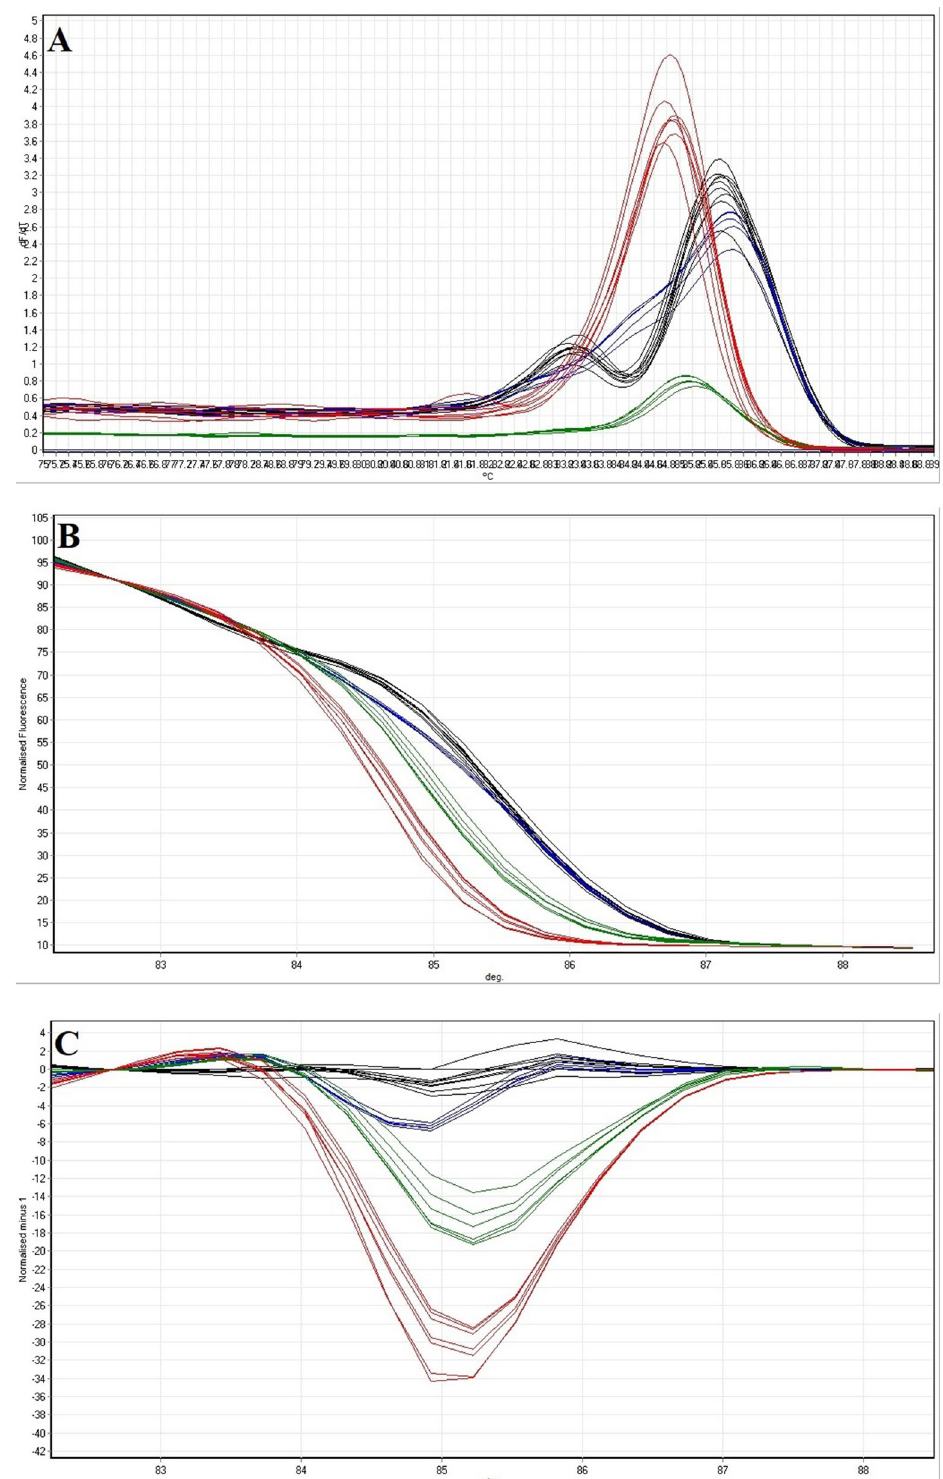
Figure 7. ( A ) Melting curves, ( B ) normalised melting curves and ( C ) difference plots the Shigella isolates from stool samples analysed by PCR-HRM assay. Green curve: S. dysenteriae . Red curve: S. flexneri . Blue curve: S. boydii . Black curve: S. sonnei